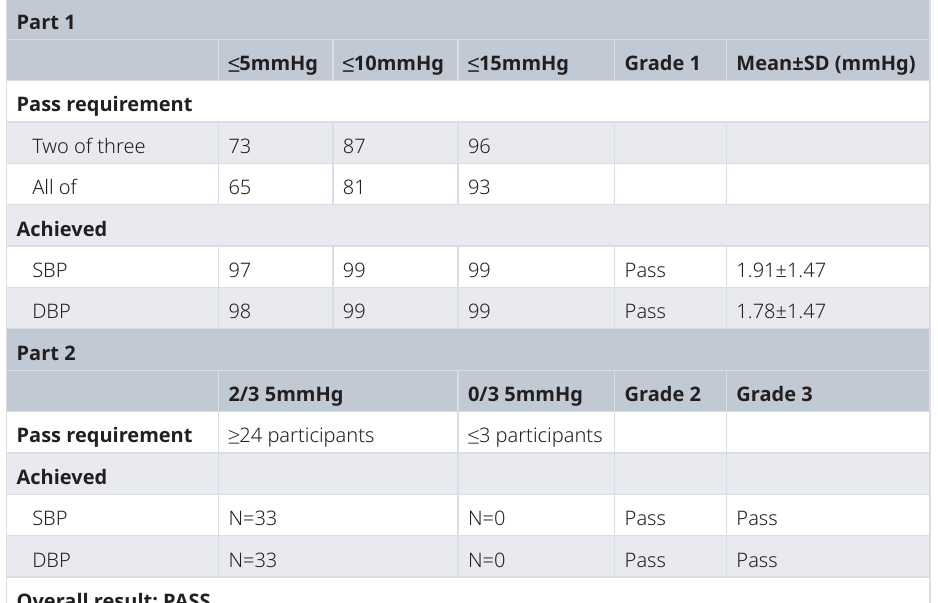
Table 3. Validation results.